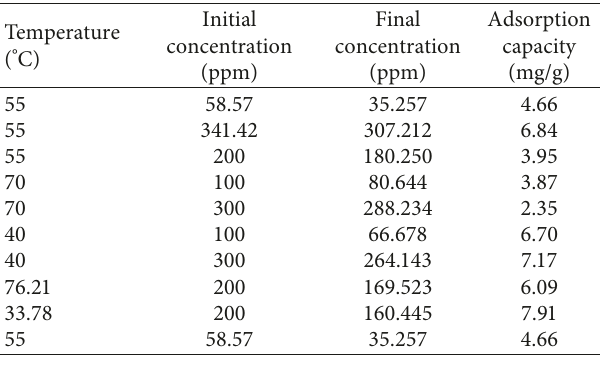
Table 3: Influence of temperature and initial concentration on nickel uptake.